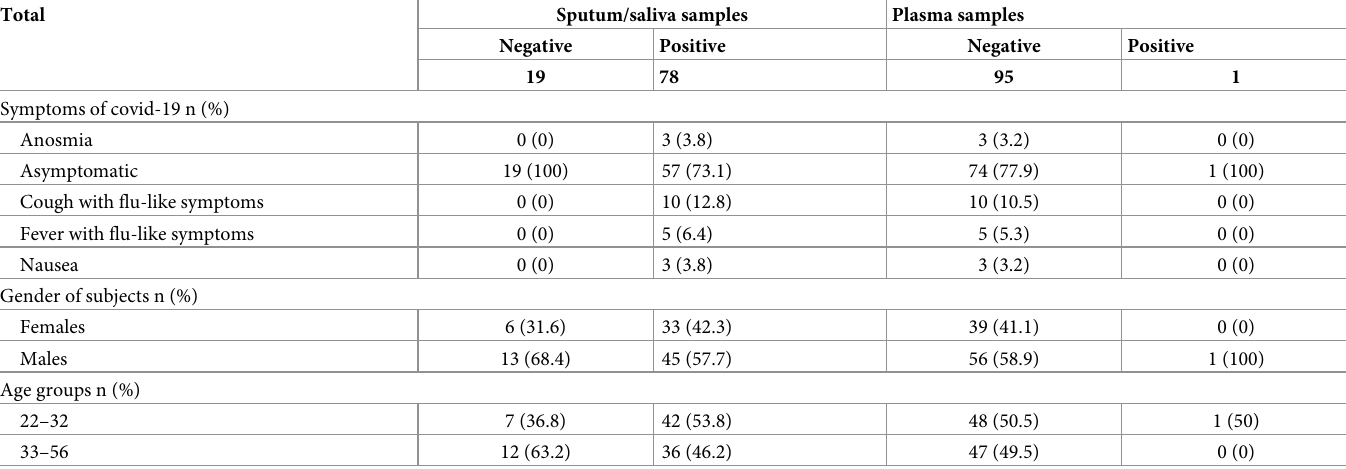
Table 1. Virus characteristics of participants with suspected COVID-19 providing either blood or sputum